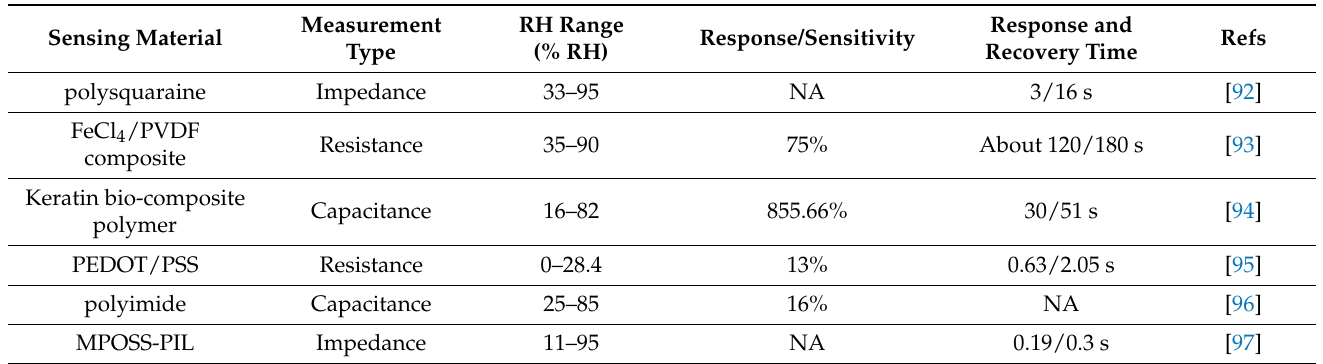
Table 3. The comparison of polymer based electrical type humidity sensors.